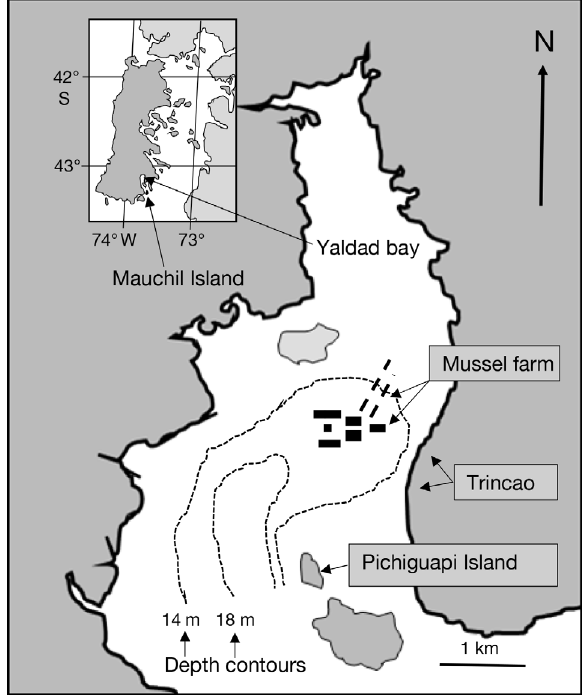
Fig. 1. Geographic location of Yaldad Bay and Mauchil Is- land, Chile, and the 3 study polygons: mussel farm, Trincao seashore and Pichiguapi